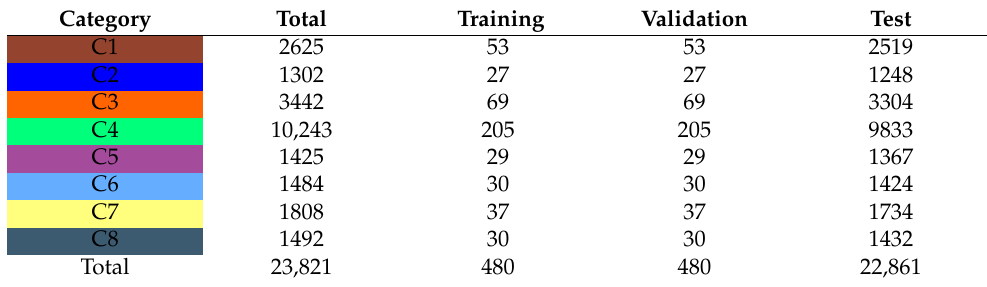
Table 4. Category information and corresponding experimental sample size for ZY.